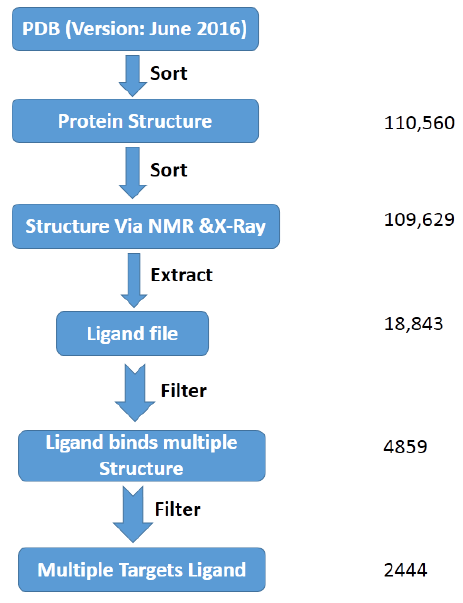
Table 1. A comparison of the updated MTLD with the previous version of MTLD.